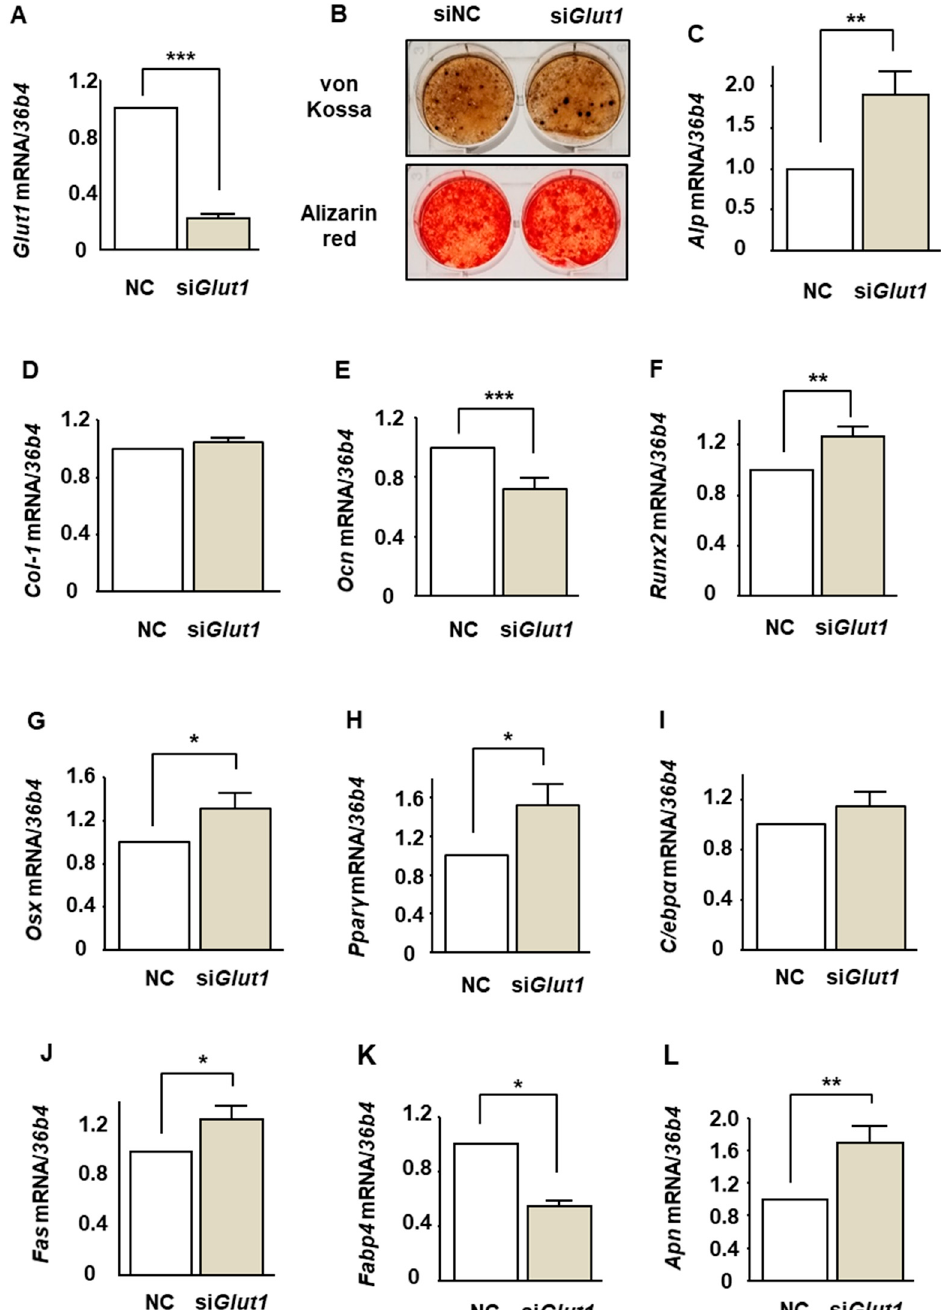
Figure 5. The effects of Glut1 silencing on mineralization and the expression of osteoblast and adipocyte differentiation markers in ST2 cells. ( A , C – L ) After transfection of siRNA for Glut1 and non-specific control, the cells were incubated in osteoblast differentiation medium for 3 days. Thereafter, the mRNA expression of osteoblastogenic markers ( Alp , Col-1 , Ocn , Runx2, and Osx ) and adipogenic markers ( Pparg , C/ebpa , Fas , Fabp4, and Apn ) was examined by real-time PCR. 36b4 was used to normalize the differences in the efficiencies of reverse transcription. The results are expressed as mean ± SE ( n ≥ 10). * p < 0.05, ** p < 0.01, *** p < 0.001. NC; negative control. ( B ) After transfection of siRNA, the cells were incubated in osteoblast differentiation medium, and the mineralization staining was performed on day 14.